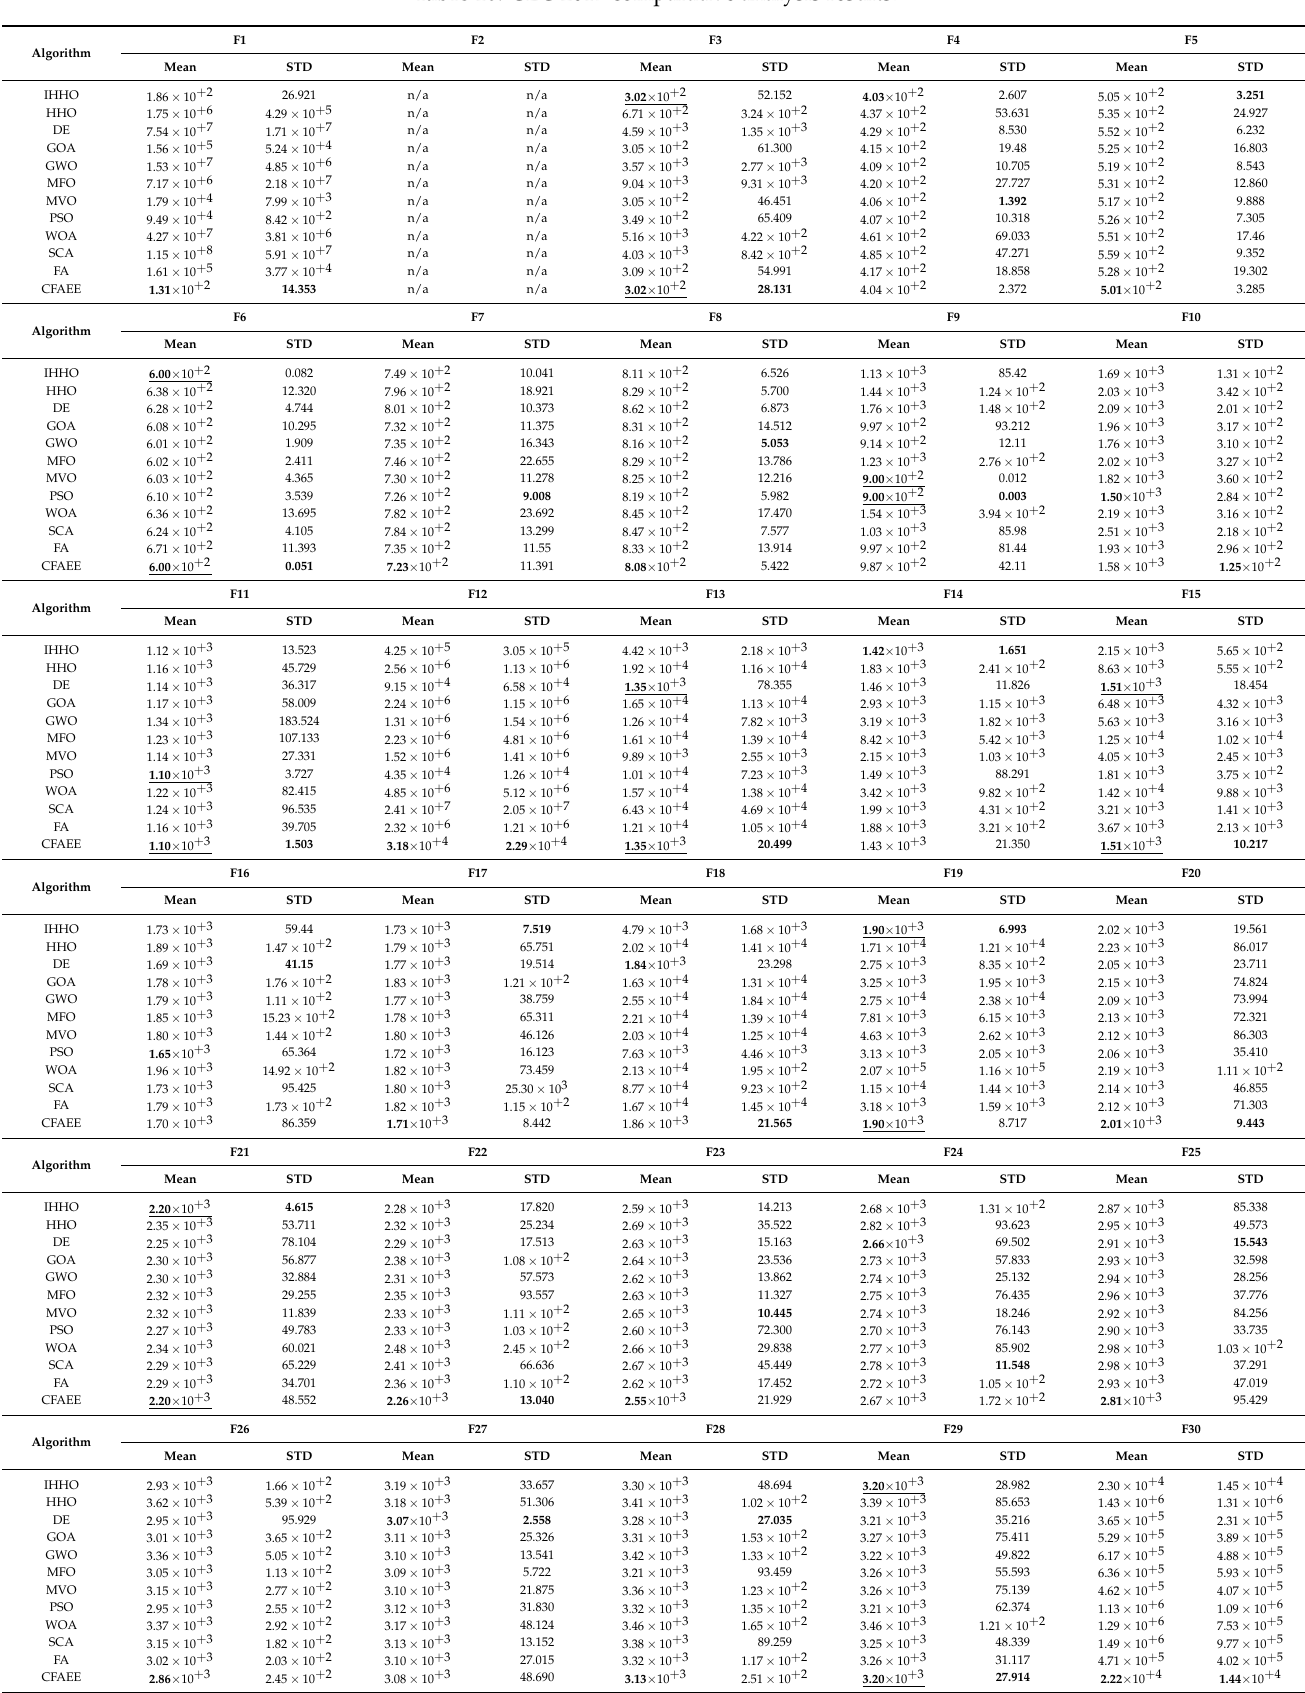
Table 10. CEC 2017 comparative analysis